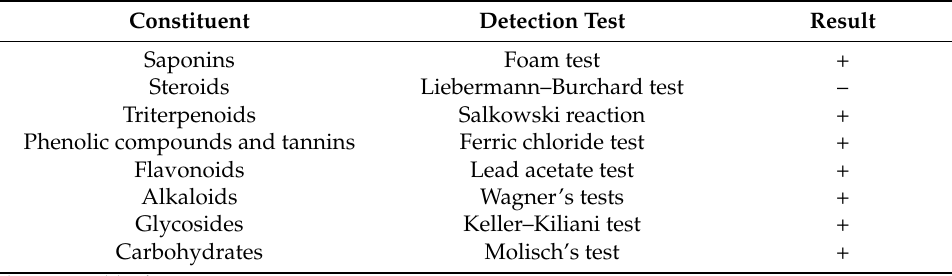
Table 1. Qualitative phytochemical screening of R. gallica var. aegyptiaca